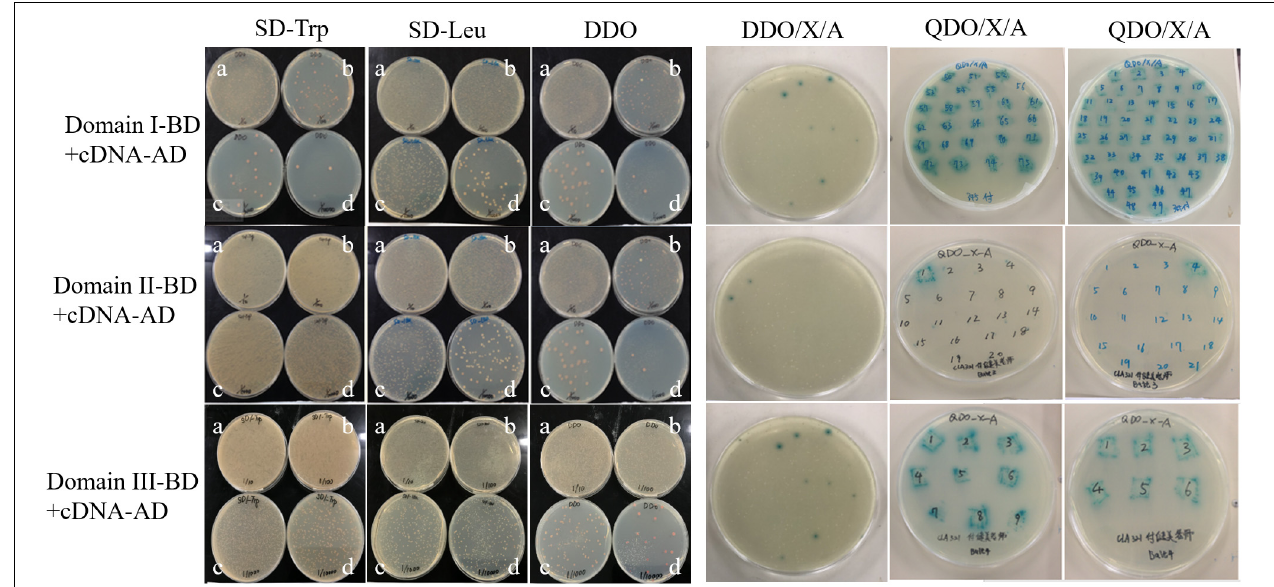
FIGURE 2 | Cry1Ab/c-interacting endogenous proteins were preliminarily screened. The growth of three co-transformed Y2HGold yeast harboring Domain-BD and the Y187 yeast strain harboring cDNA-AD on nutrient-deficient SD/-Trp, SD-Leu, DDO, DDO/X/A, and QDO/X/A, respectively. a-d, the dilution ratios is 1/10, 1/100, 1/1000, 1/10000,